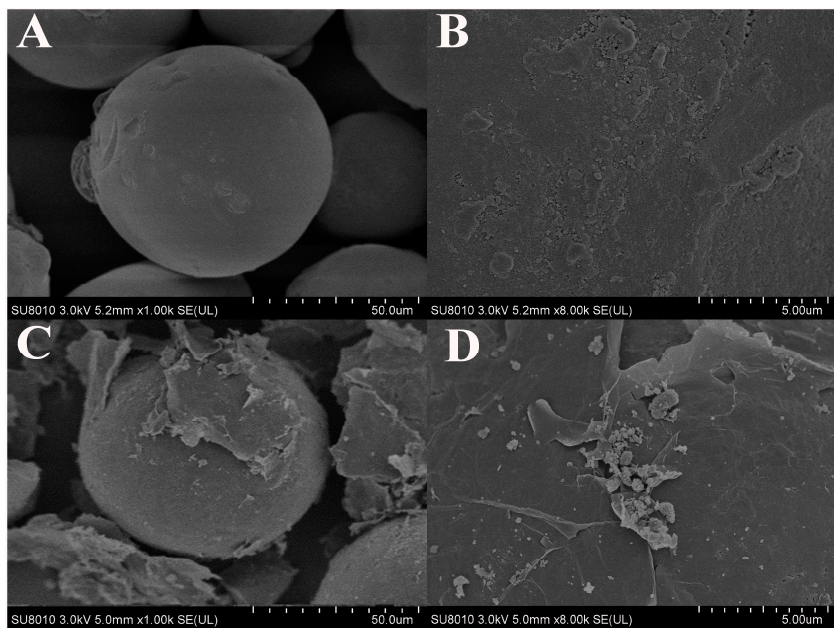
Figure 1. ( A ) SEM image and ( B ) high-magnification SEM image of aminosilica; ( C ) SEM image and ( D ) high-magnification SEM image of rGO@silica sorbent.